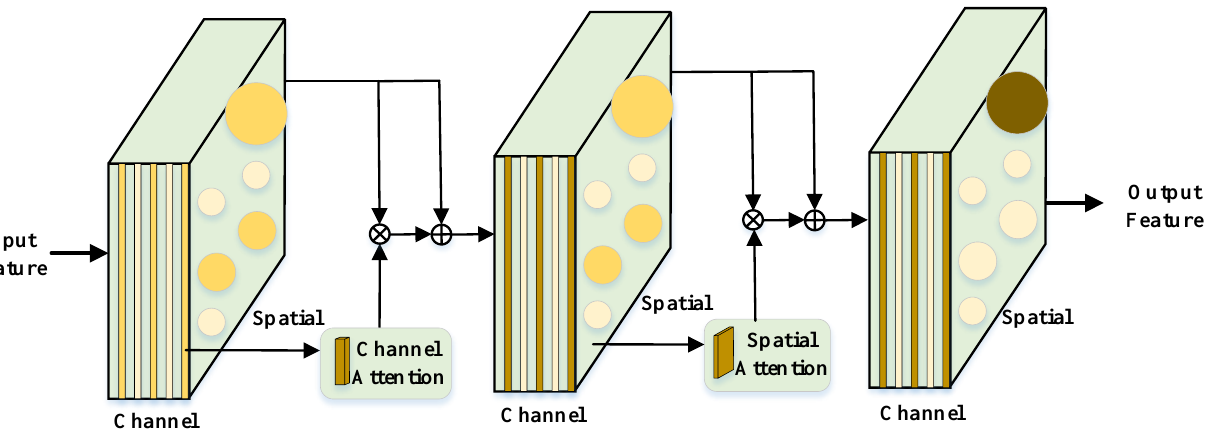
Figure 4. Attention mechanism.